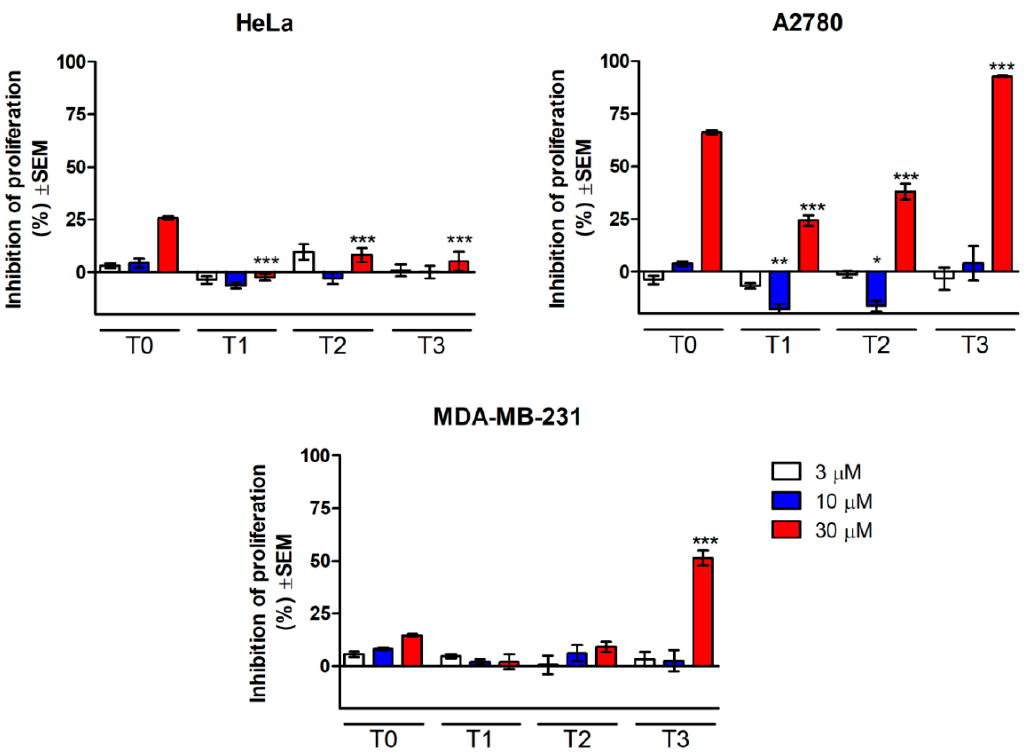
Figure 4. Changes in the cell viability of HeLa, A2780, and MDA-MB-231 cancer cells caused by the solutions of tazarotene following photocatalytic degradation. Cells were treated with 3, 10, and 30 µ M solutions of tazarotene after UV irradiation (T0—without irradiation, T1—0.5 h of irradiation, T2—1 h of irradiation, and T3—2 h of irradiation): * p < 0.05, ** p < 0.01, and *** p < 0.001.